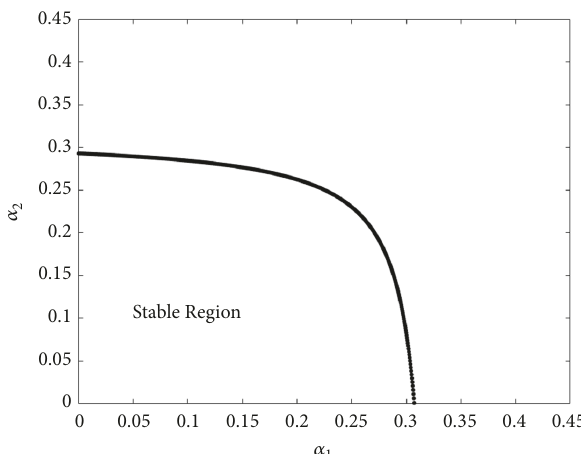
Figure 2: Local stable region of the Nash equilibrium point about (𝛼